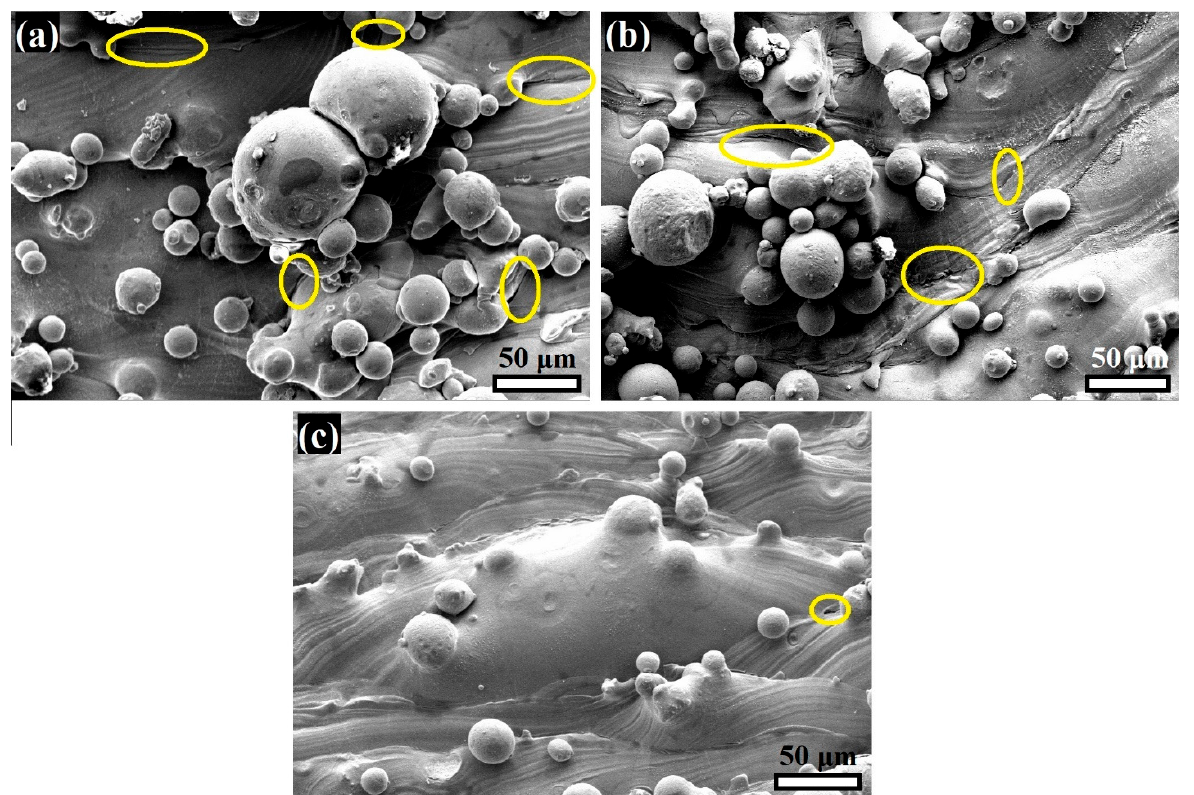
Figure 7. SEM images of the surface morphology of the printed 316L-SS specimens: ( a ) T0.6, ( b ) T1, and ( c ) T1.4. The yellow ovals refer to the surface fl aws.